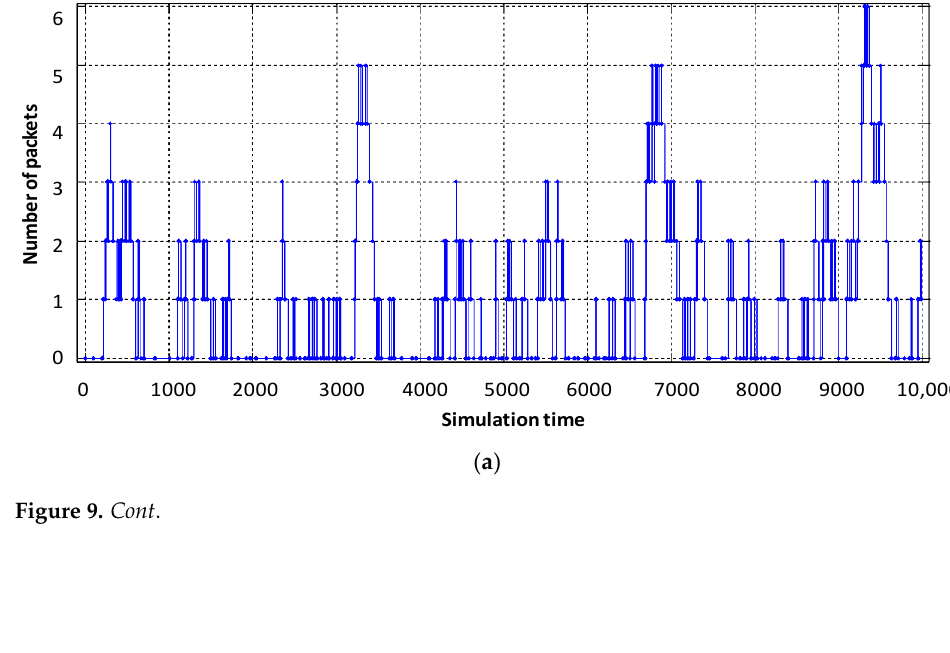
Figure 8. Service device loading of the physical router with Triple Play flows.